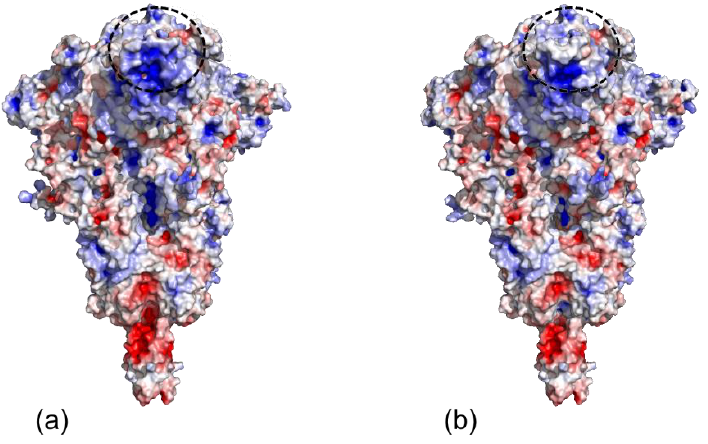
Figure 5. Comparison of antigenicity of SARS-CoV-2 Spanish and British variants. ( a ) Spanish variant. ( b ) British variant. By convention, red is negative and blue positive. Change in antigenicity indicated by the dotted circle.